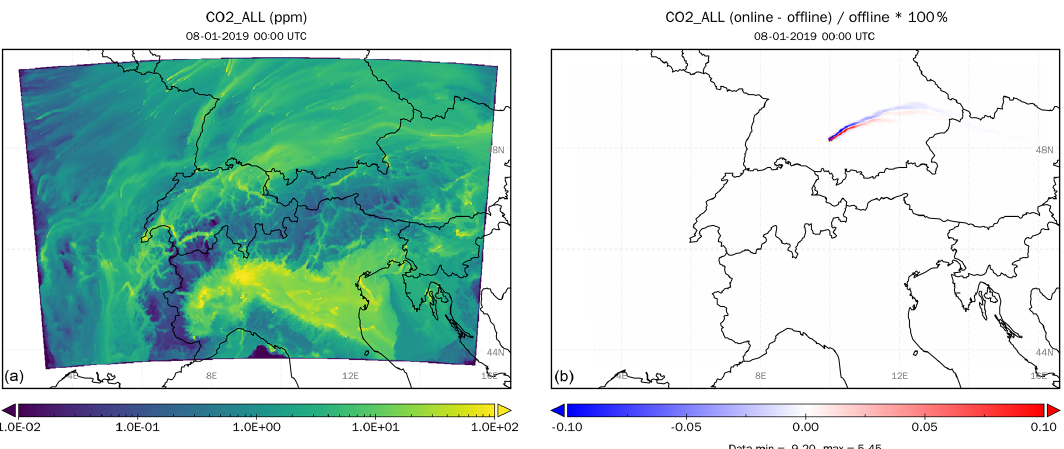
Figure 3. Surface-layer concentrations for the online simulation (a) and relative differences between online and offline simulations (b) of the CO 2 tracer corresponding to all anthropogenic emissions after 7d in the COSMO-GHG test case.